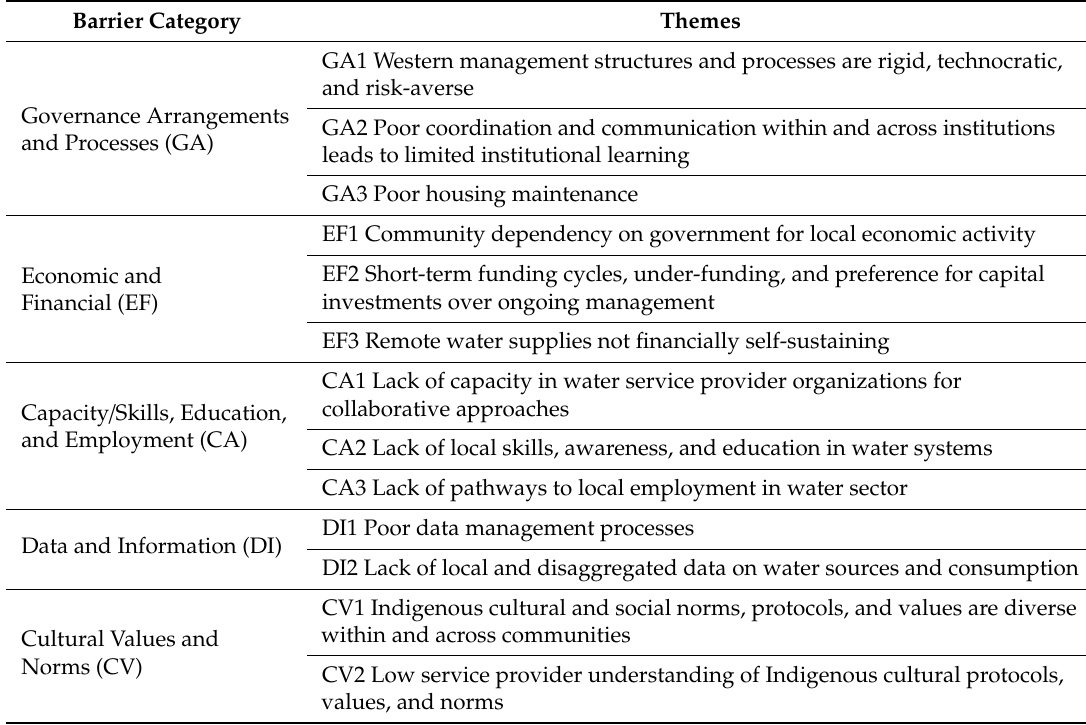
Table 2. Barrier categories and